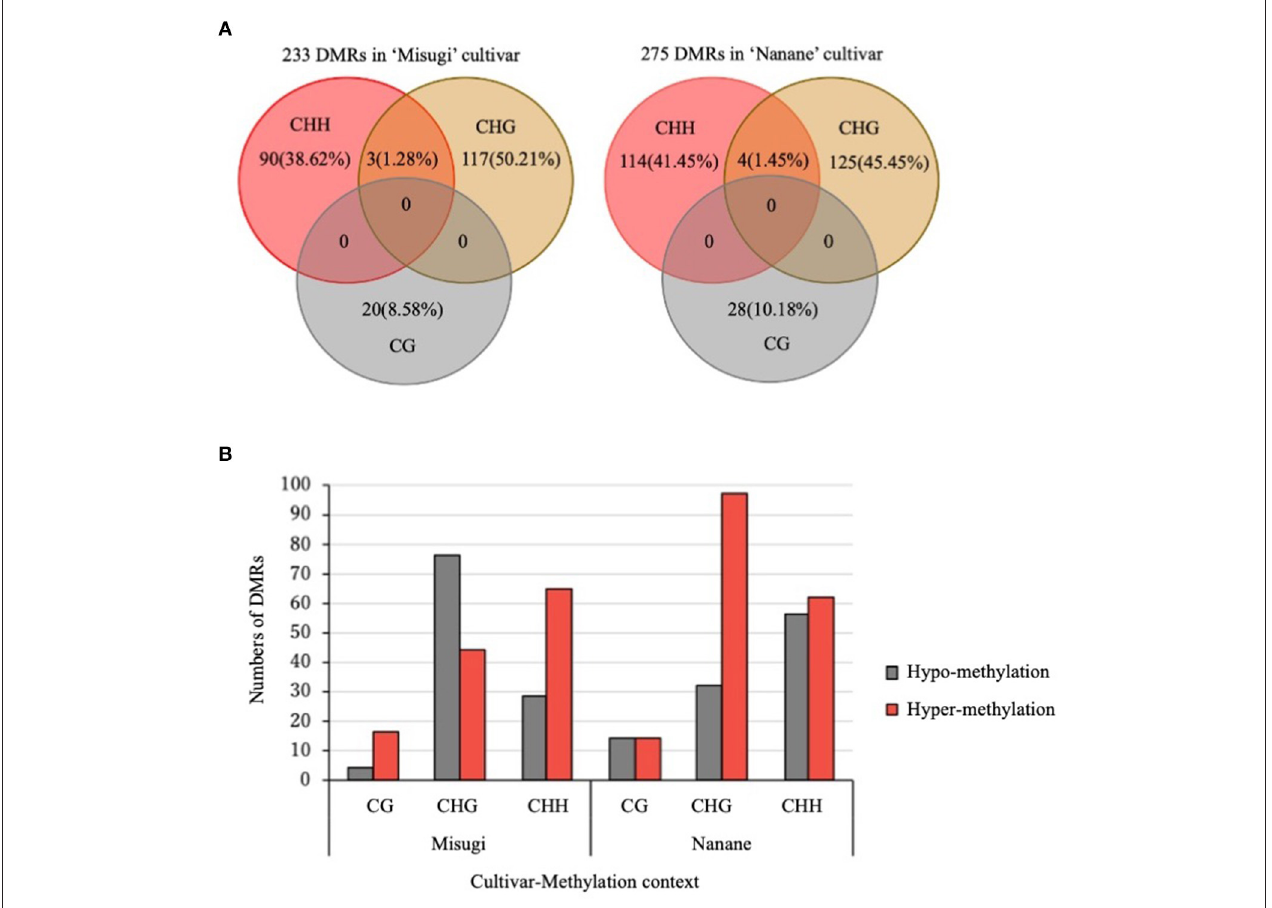
FIGURE 3 | Differentially methylated regions (DMRs) between control cotyledons and cotyledons infected with A. candida of B. rapa cultivars “Misugi” (susceptible) and “Nanane” (resistant). (A) Total number and percentage of putative CG, CHG, and CHH DMRs. (B) Methylation status of 233 and 275 DMRs in “Misugi” (susceptible) and “Nanane” (resistant),